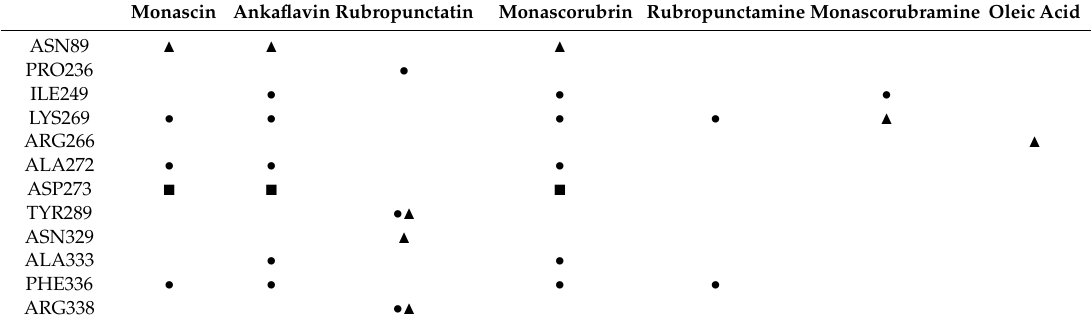
Table 6. Lipase (PDB: 1EHT) interacts with docked Monascus pigments. ( • : hydrophobic interactions; (cid:78) : hydrogen bonds; (cid:4) : electrostatic bonds).